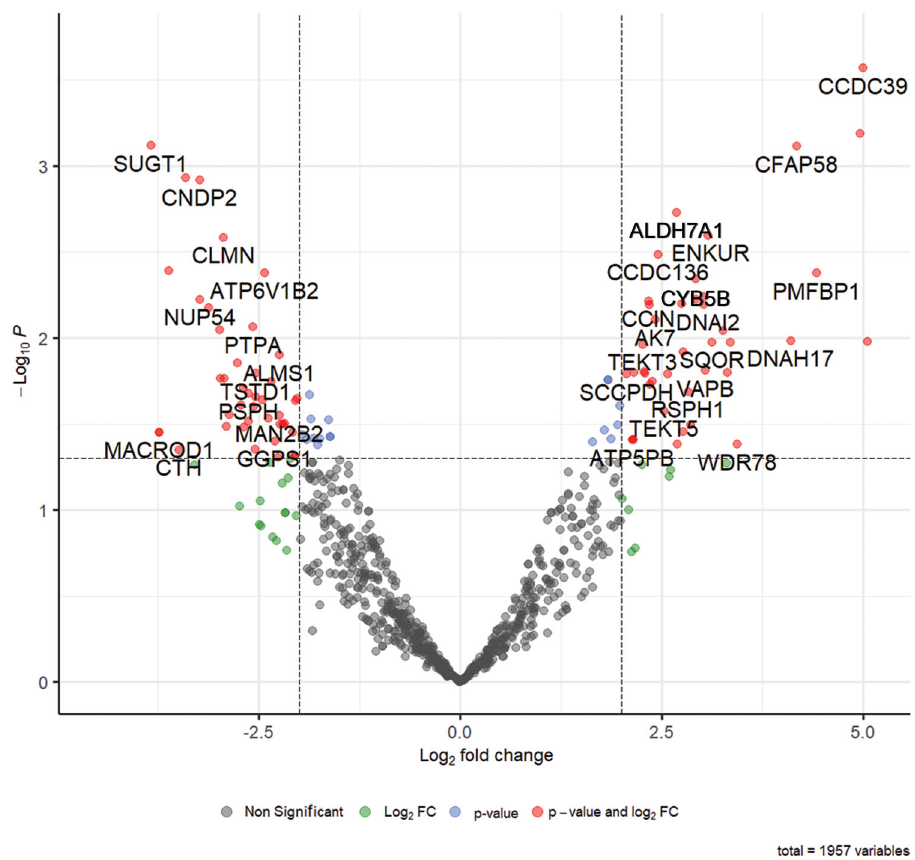
Fig. 3 Volcano plot representation of changes in zincoprotein abundances before and after 4 h of in vitro capacitation. Fold change threshold = 2.0 ( x -axis) and unadjusted P -value ≤ 0.05 ( y -axis). Red circles represent zincoproteins above the fold change and unadjusted P -value threshold; blue circles represent those above the unadjusted P -value threshold but below the fold change threshold; green circles represent zincoproteins above the fold change but below the unadjusted P -value threshold; and gray circles represent those that are below both